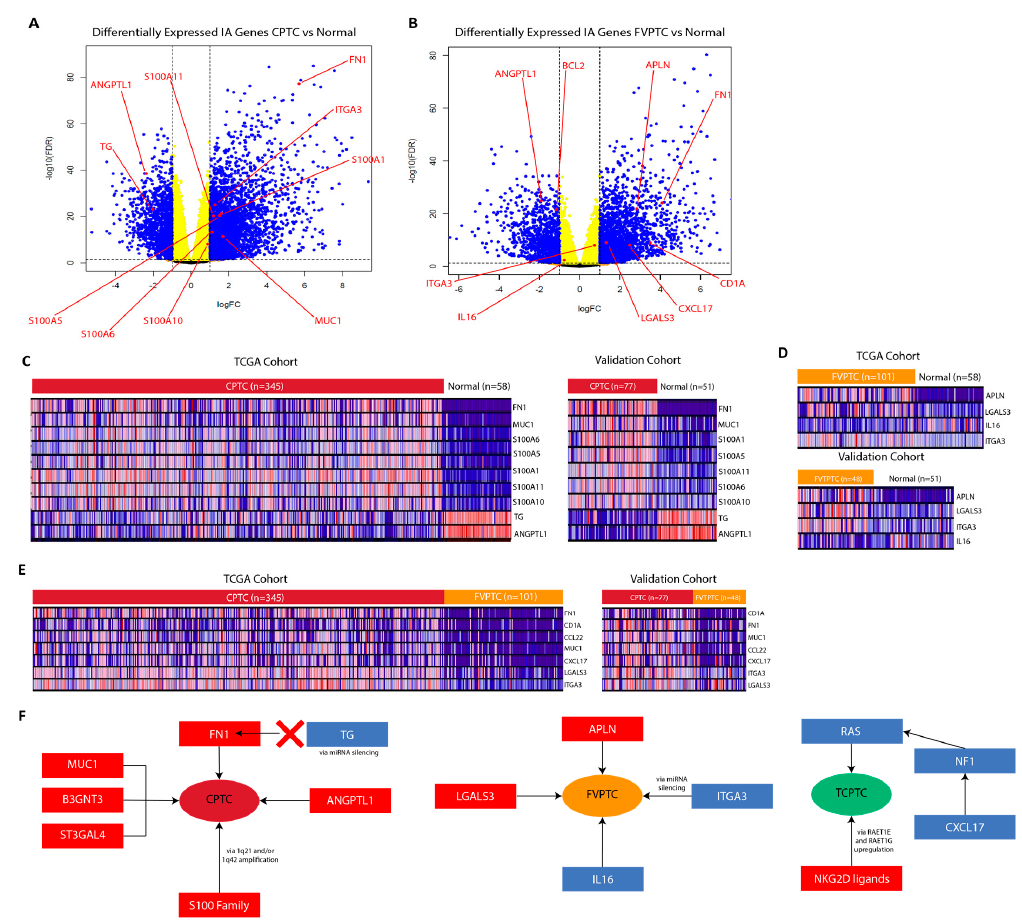
Figure 7 : Validation of CPTC and FVPTC CA and IA gene dysregulation. Volcano plots for ( A ) the CPTC vs normal comparison and ( B ) the FVPTC vs normal comparison using the validation RNA-seq data. Genes of interest are indicated with red labels. Heatmaps comparing the landscapes of significantly dysregulated CA and IA genes between the validation cohort and TCGA cohort for ( C ) the CPTC vs normal comparison, ( D ) the FVPTC vs normal comparison, and ( E ) the CPTC vs. FVPTC. ( F ) Summary of most important findings. Arrows indicate possible interactions suggested by analysis and previous studies, red boxes indicate upregulation, and blue boxes represent downregulation.